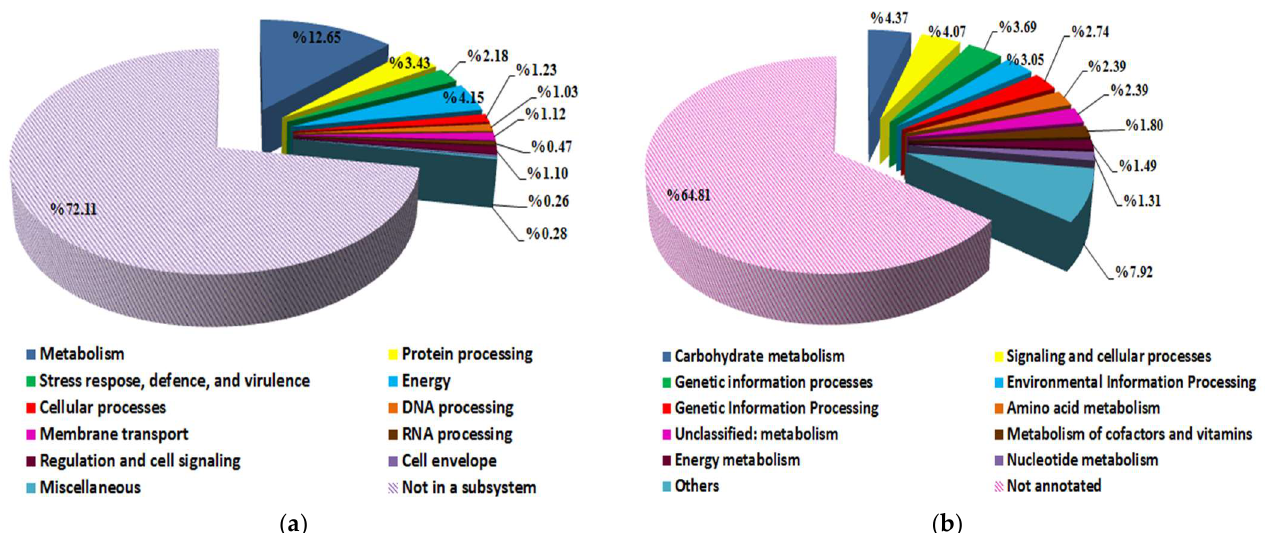
Figure 4. ( a ) a subsystem analysis by PATRIC platform indicates the number of genes incorporated in specific biological process within the genome of S. vinaceusdrappus strain AC-40; ( b ) a functional categorization of KEGG annotations of the genome of S. vinaceusdrappus strain AC-40 using the GhostKOALA tool. Table 1. The biosynthetic gene clusters (BGCs) detected with AntiSMASH within the genome of Streptomyces vinaceusdrappus strain